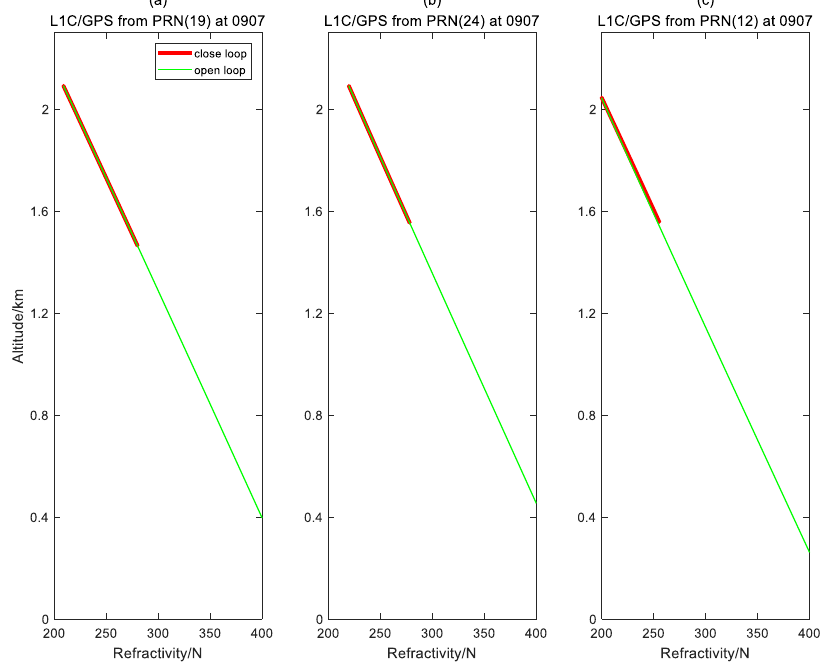
Figure 10. Refractivity profiles retrieved from observations of L1C / GPS in OL / closed-loop tracking mode. Red / green lines represent results in closed- / OL mode tracking, respectively. ( a ) G19 / GPS Occultation; ( b ) G24 / GPS Occultation; and ( c ) G12 / GPS Occultation.